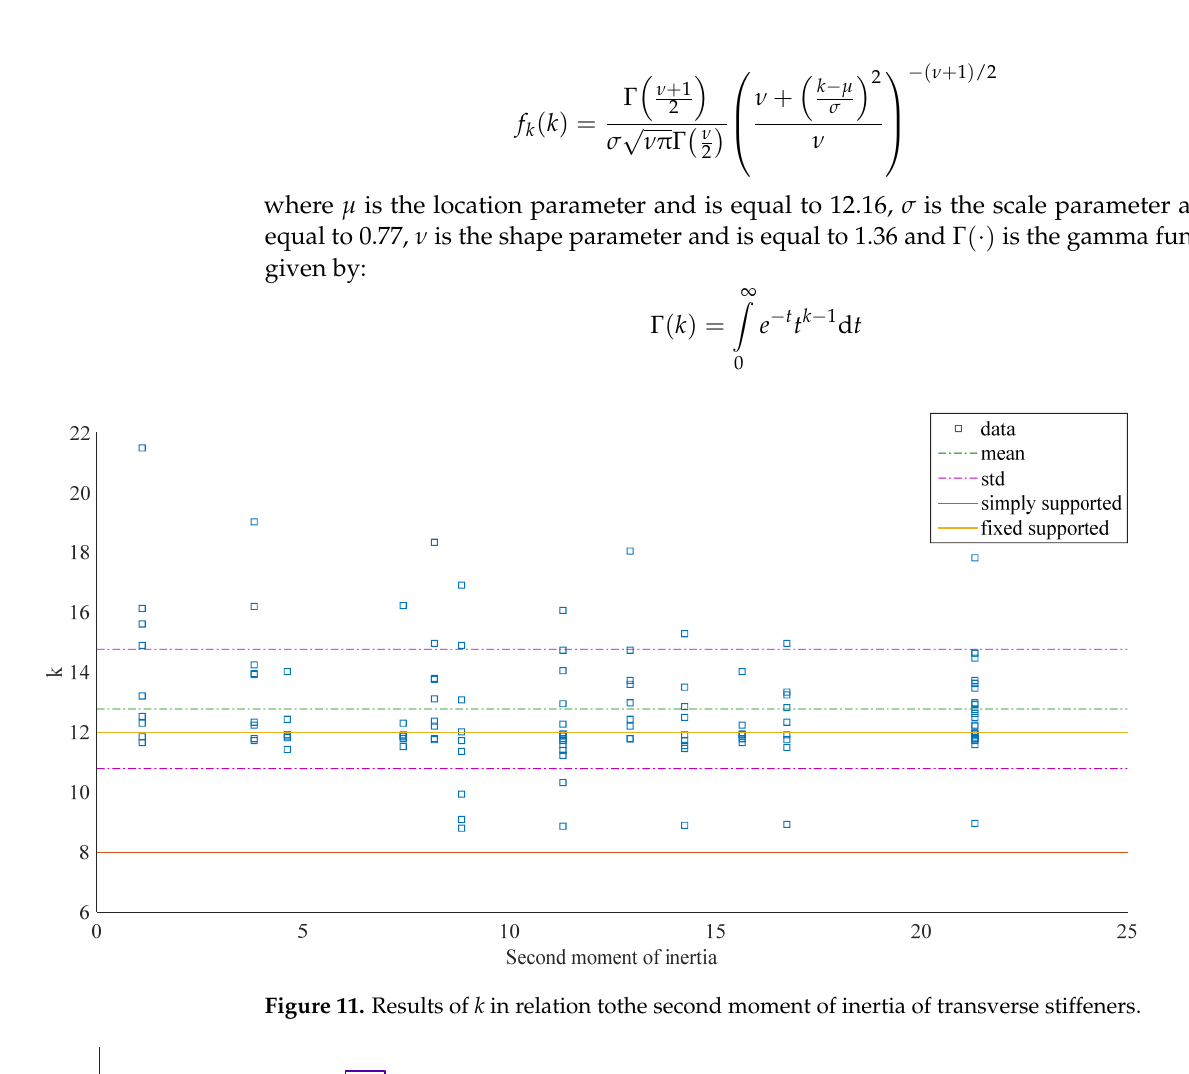
Figure 10. Stiffener bending normal stresses and deformation of a weak ( a ) and strong ( b ) stiffener system.